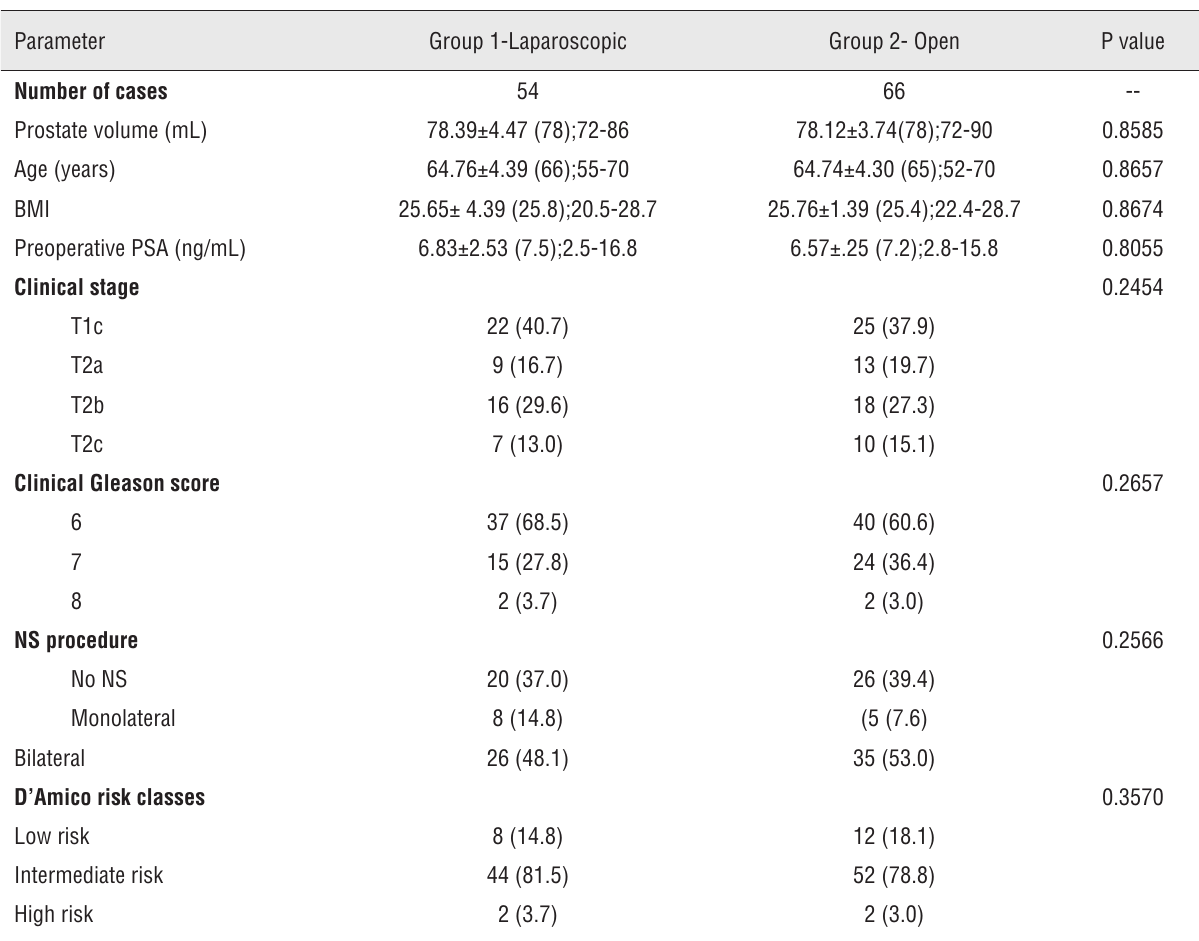
Table 1 - patient demographics in the two groups (Lp versus open). Results are presented as mean±sD (mean) and range or number (%) of